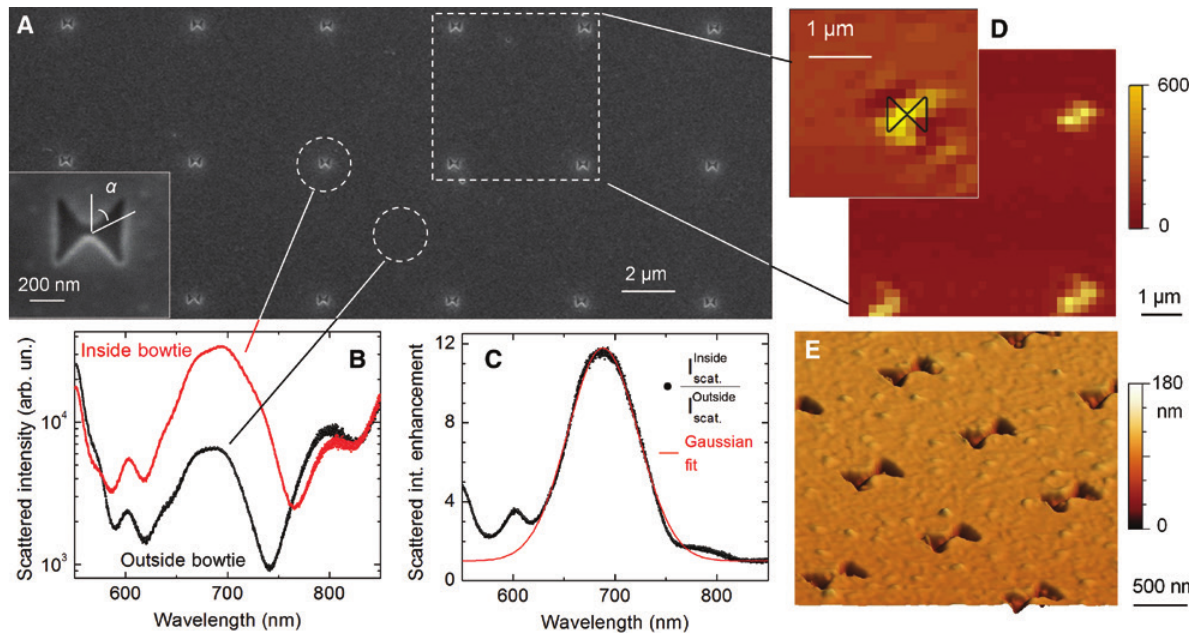
Figure 3: Bowtie NA